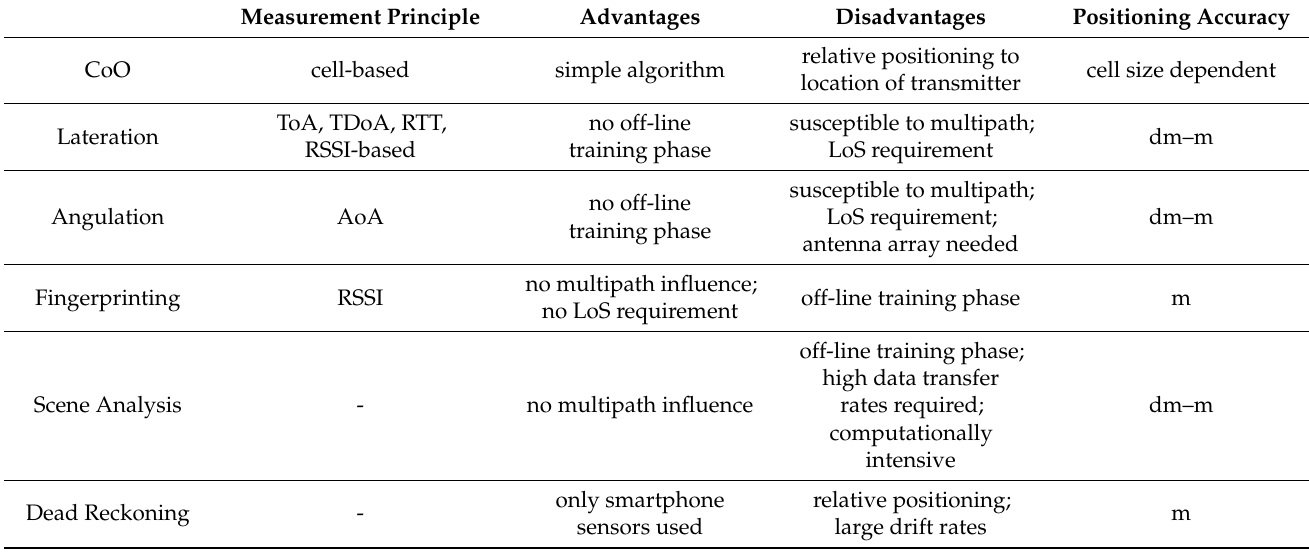
Table 2. Characteristics of positioning methods.